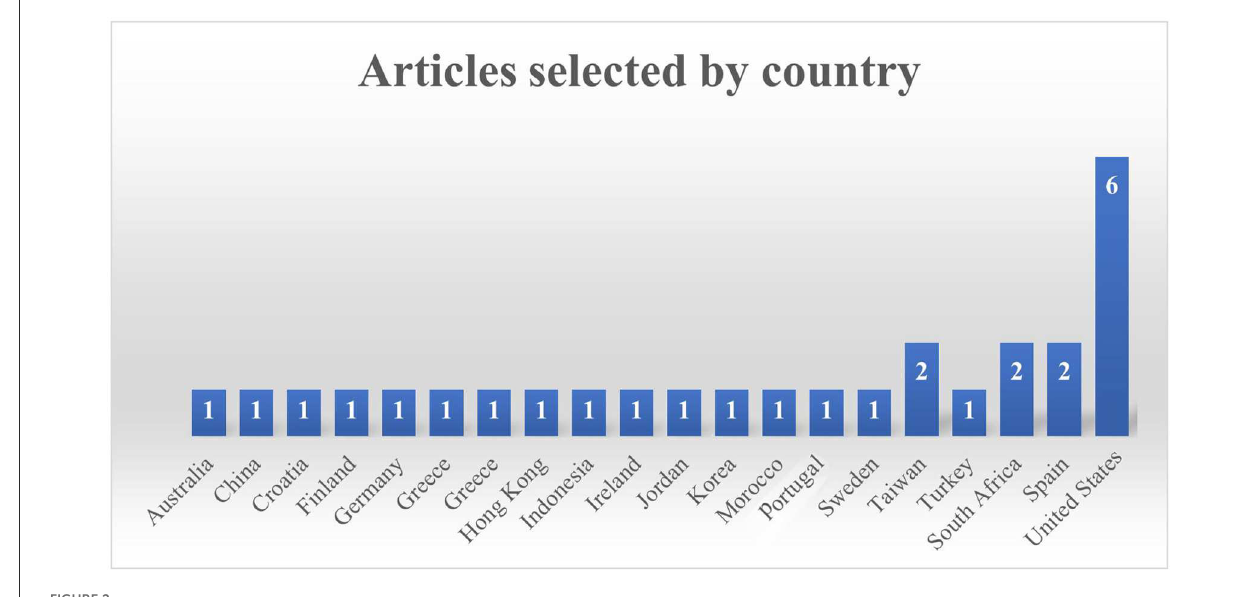
FIGURE2 Number of articles based on country.